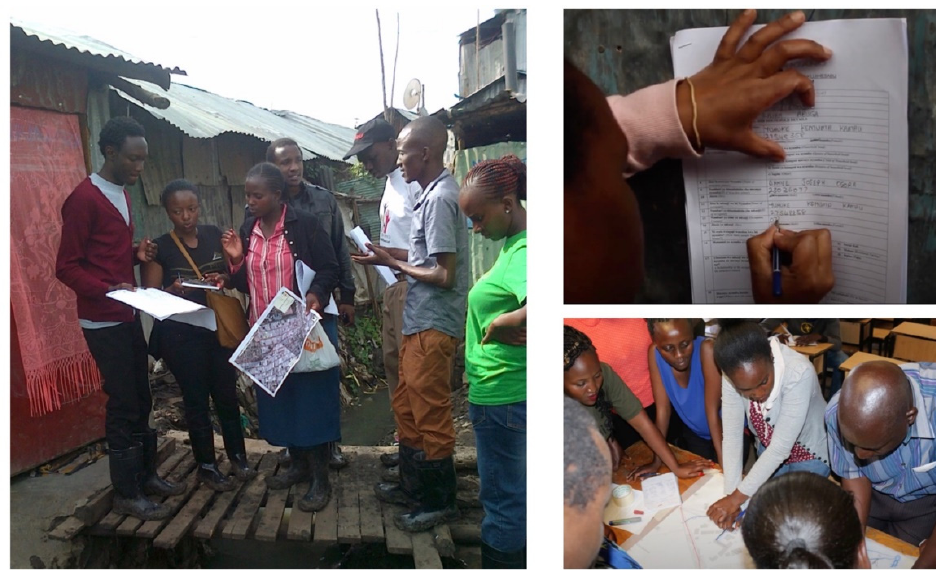
Figure 6. Resident and Youth Field Researchers ( left ), a household survey ( top right ), and a community planning meeting interpreting citizen science and generating climate justice solutions ( bottom right ).